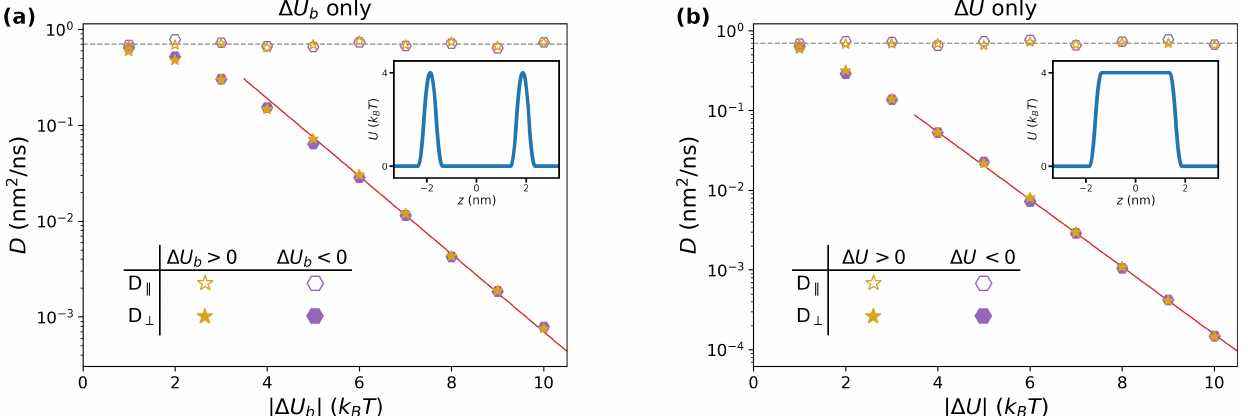
Figure 3. ( a ) Dependence of long-time diffusion coefficients on the size of the barriers | ∆ U b | , for ∆ U = 0 and D = D wat . The horizontal dashed line corresponds to D wat = 0.7 nm 2 /ns. The red lip continuous line is obtained by fitting the values for | ∆ U b | > 5 k B T via an exponential function. In the inset, we report a representative potential of mean force U ( z ) for this study, corresponding to ∆ U = 4 k B T ; ( b ) same as ( a ), but focusing on varying | b In the inset, we report U ( z ) for ∆ U = 4 k B T